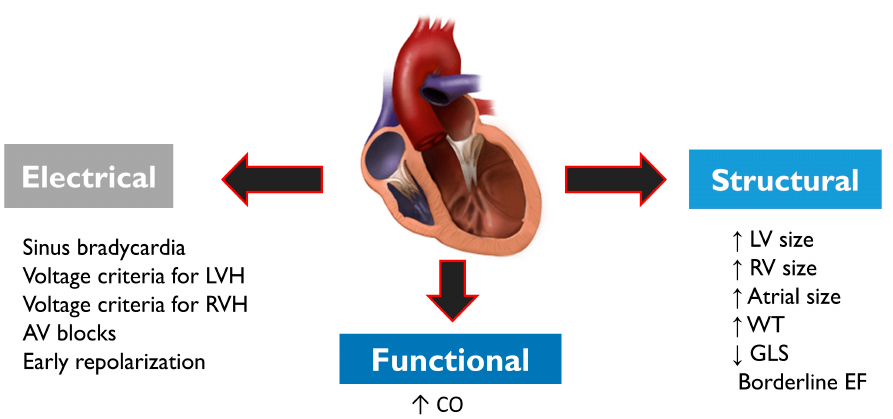
Figure 4. Structural, electrical and functional physiological changes commonly observed in athletes. Physiological changes may overlap with cardiac conditions that may pose a risk of SCD, and there- fore differential diagnosis is very important. Abbreviations: AV—atrioventricular; CO—cardiac output; EF—ejection fraction; GLS—global longitudinal strain; LV—left ventricle; LVH—left ventricular hypertrophy; RV—right ventricle; RVH—right ventricular hypertrophy; WT: wall thickness.